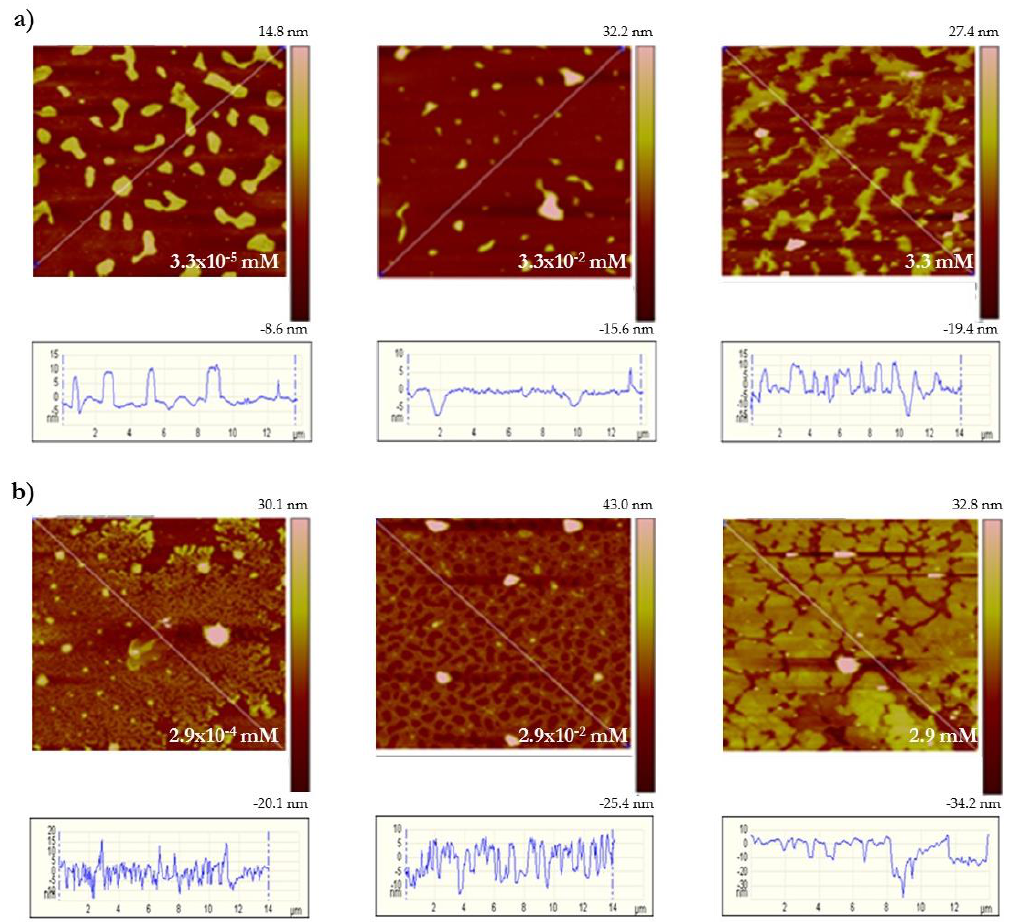
Figure 8. AFM images (tapping mode, 10 × 10 µm 2 ) obtained for layers obtained for the deposition of DSPE-PEG+surfactant mixtures containing different surfactant and solution concentration: ( a ) CB and ( b ) SLES + CB (molar ratio 3:2). All the mixtures contain a fixed DSPE-PEG concentration of 5 g / L, and their ionic strength and pH were fixed a 40 mM (KCl) and 5.6,